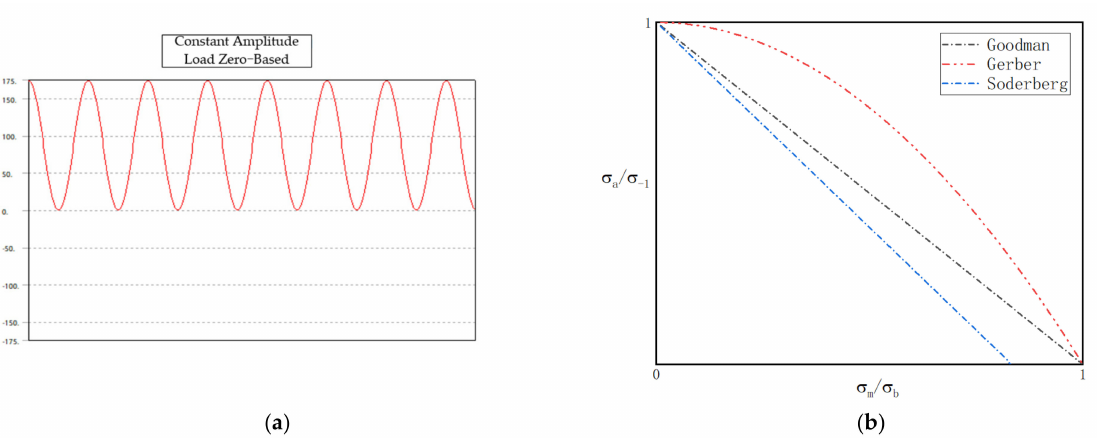
Figure 19. Sinusoidal load spectrum of the rotating arm: ( a ) sinusoidal load spectrum; ( b ) Goodman formula.